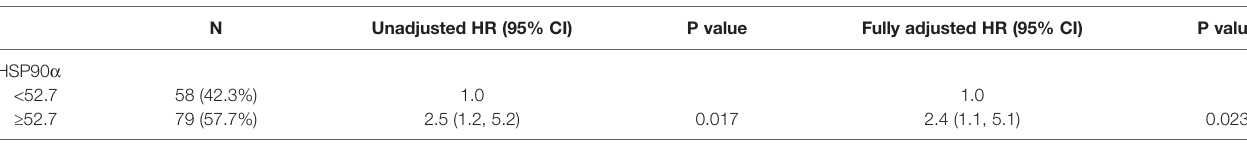
TABLE 5 | Unadjusted and adjusted Cox proportional hazards model for